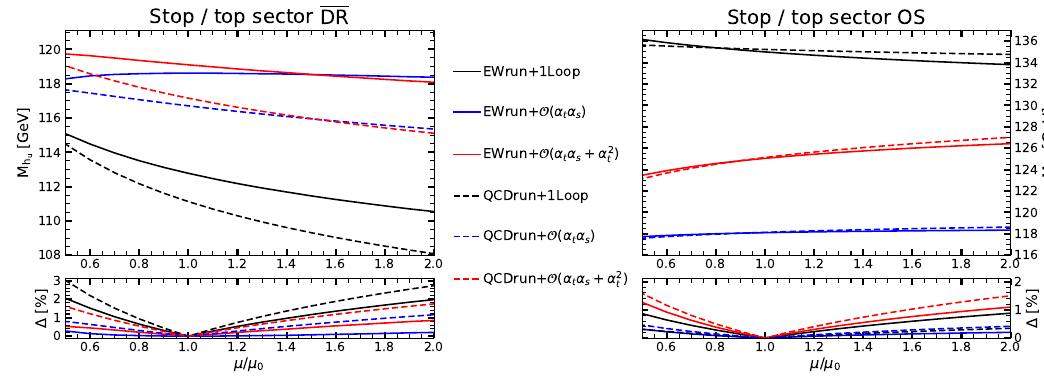
Figure 11 . Upper Panel: the mass of the h u -like Higgs boson at one-loop level (black) and at two-loop level including the O ( (cid:11) t (cid:11) s ) corrections (blue) and the O ( (cid:11) t (cid:11) s + (cid:11) 2 ) corrections (red) as s a function of the renormalization scale (cid:22) R = (cid:22) varied between 1/2 and 2 times the central value (cid:22) R = (cid:22) 0 , for EW running (full) and QCD running (dashed), see text for explanation. Lower Panel: absolute value of the relative deviation of the result obtained at (cid:22) R = (cid:22) with respect to the result at (cid:22) R = (cid:22) 0 | i.e. (cid:1) = j M (cid:22) (cid:0) M (cid:22) 0 j =M (cid:22) 0 | in percent as a function of (cid:22) at one-loop (black), h u h u h u two-loop O ( (cid:11) t (cid:11) s ) (blue) and two-loop O ( (cid:11) t (cid:11) s + (cid:11) 2 ) (red) level for EW running (full) and QCD s running